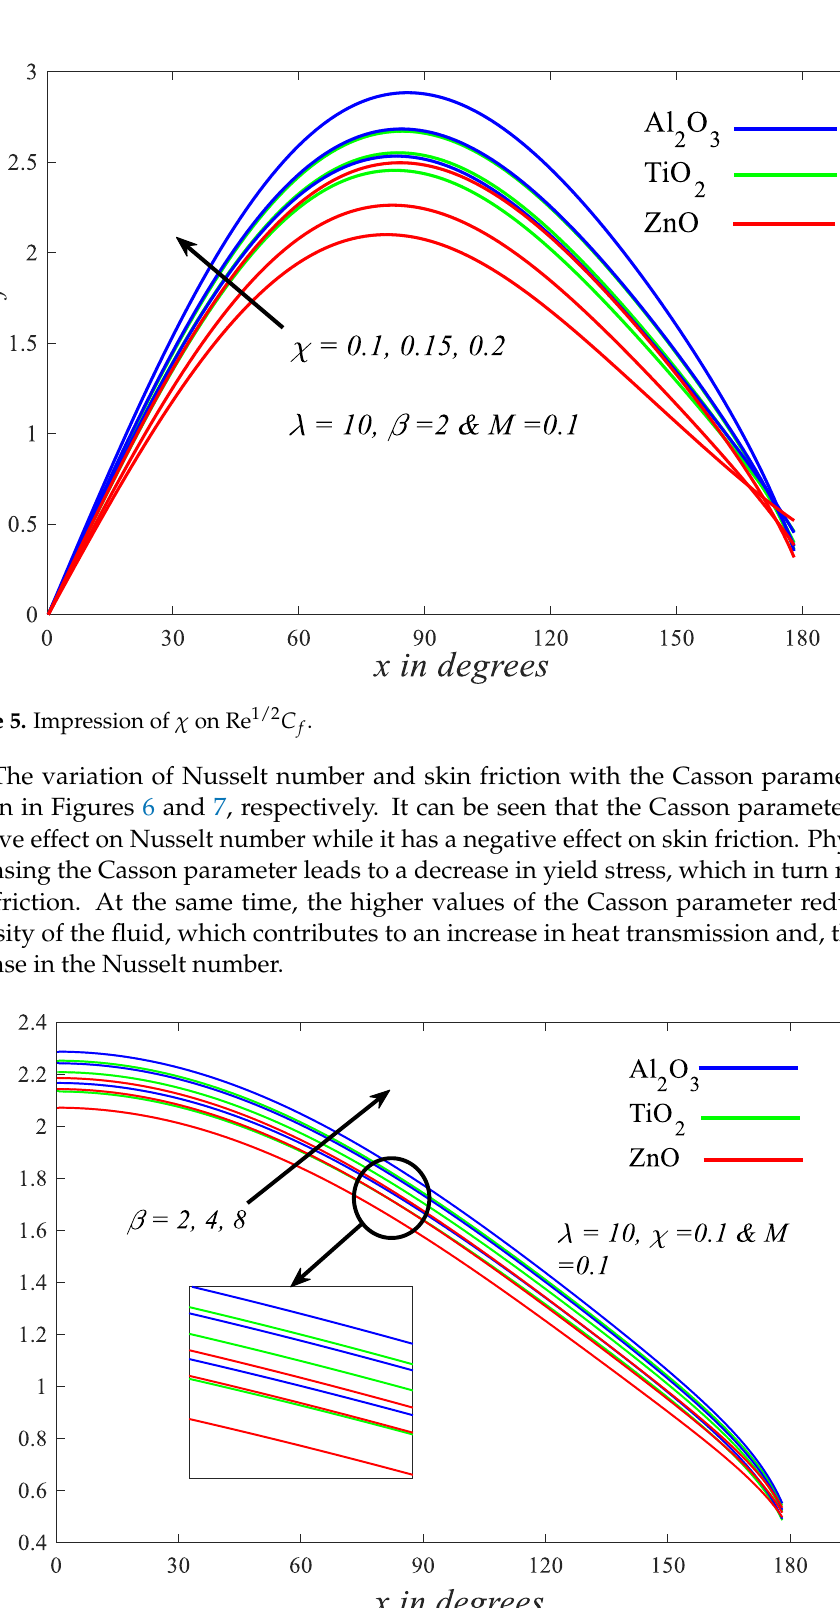
Figure 4. Impression of  on Nu . The inset is a partial enlargement of the curves.